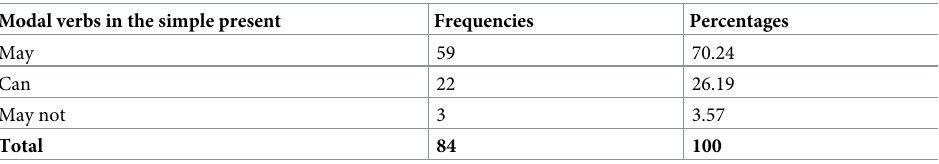
Table 8. Frequencies and percentages of modal verbs in the simple